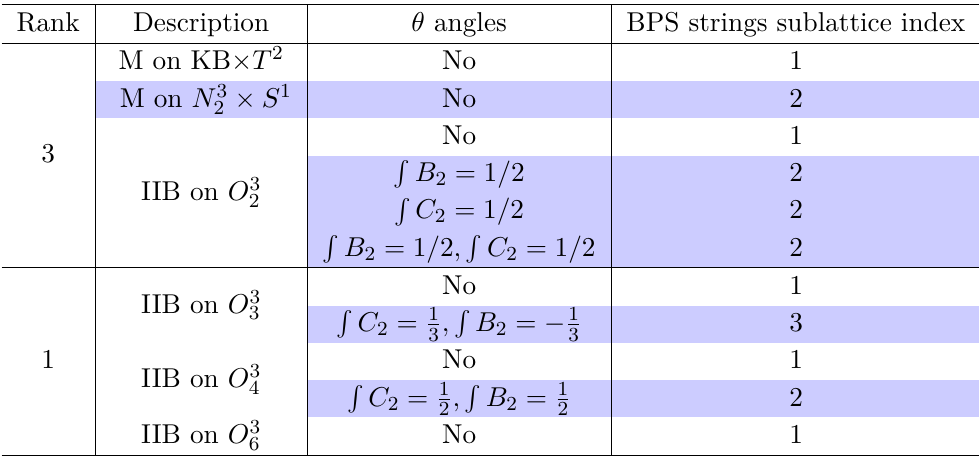
Table 1 . table of the low-rank ( r ≤ 3 ) components of the moduli space with sixteen supercharges in seven dimensions, their descriptions in terms of smooth supergravity backgrounds, including possible discrete theta angles and the index of the sublattice of BPS strings in each case. The entries shaded in blue represent the new components of moduli space discussed in this paper. In the case of the rank 3 theories, there may be dualities relating different components of moduli space, so that some of the possibilities may be